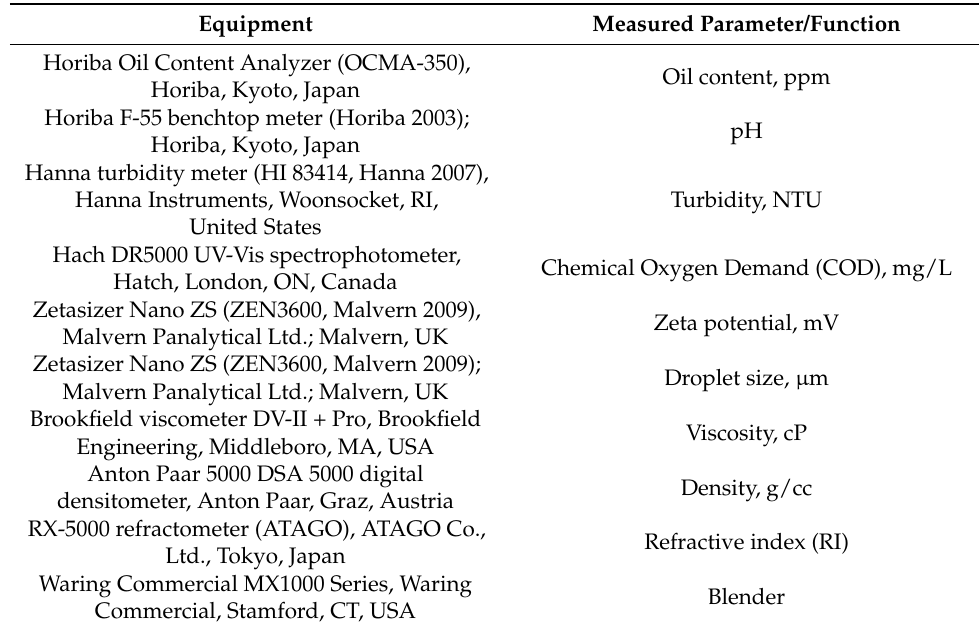
Table 3. Experimental